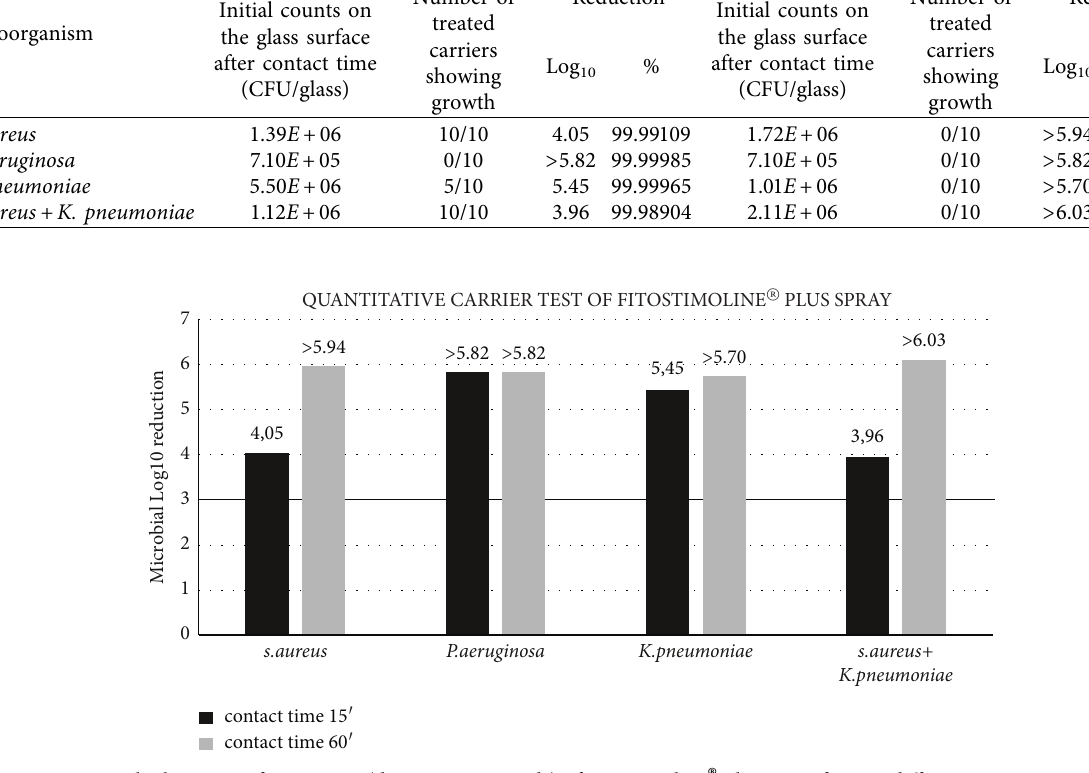
® Plus spray on a contaminated glass